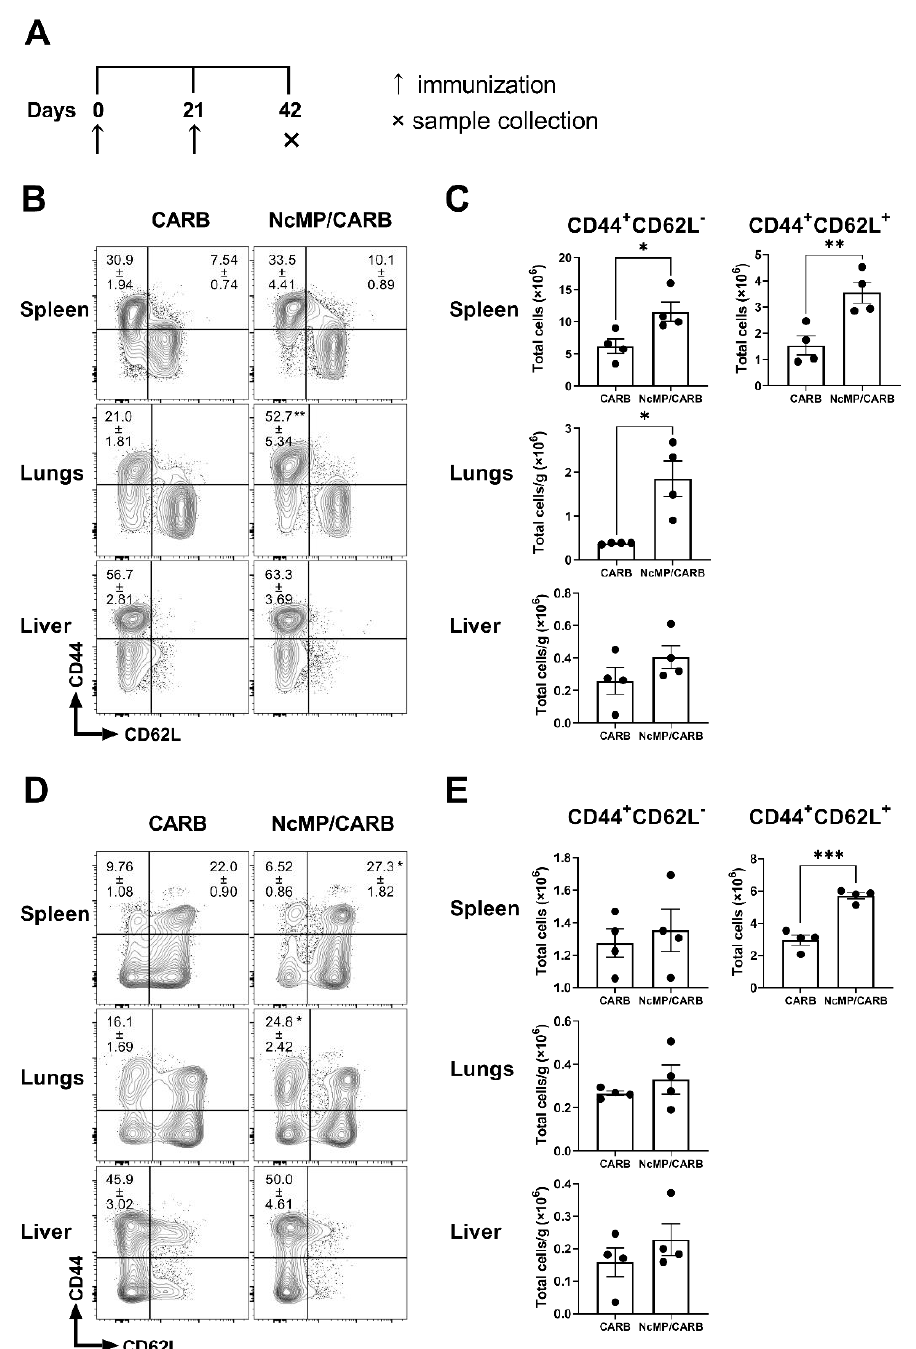
Figure 1. Memory phenotype of CD4 + and CD8 + T cells. Timeline of immunization and sample collection ( A ). Representative contour plot analysis of gated CD4 + ( B ) and CD8 + ( D ) T cells expressing CD44 and CD62L in the indicated organs, 21 days after the boost immunization. Numbers within contour plots correspond to mean percentage values ± SEM for the particular quadrant region in the respective sham-immunized (CARB) or immunized (NcMp/CARB) groups, as indicated. Numbers of CD4 + ( C ) and CD8 + ( E ) T cells presenting the cell surface phenotypes CD44 + CD62L − and CD44 + CD62L + , as indicated, in the analyzed organs of CARB and NcMp/CARB groups. In panels ( C , E ), bars represent means, and each symbol (black circle) represents an individual mouse ± SEM. Results are of one representative experiment out of two independent experiments that yielded concordant results ( n = 4 group; * p < 0.05; ** p < 0.01; *** p < 0.001, unpaired t -test).